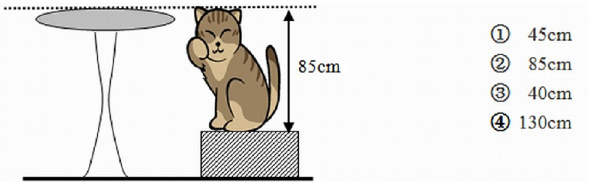
Fig 1. Sample WPS tasks: Kitty likes resting on the bench , and the bench is 45 cm high . How high is the table?